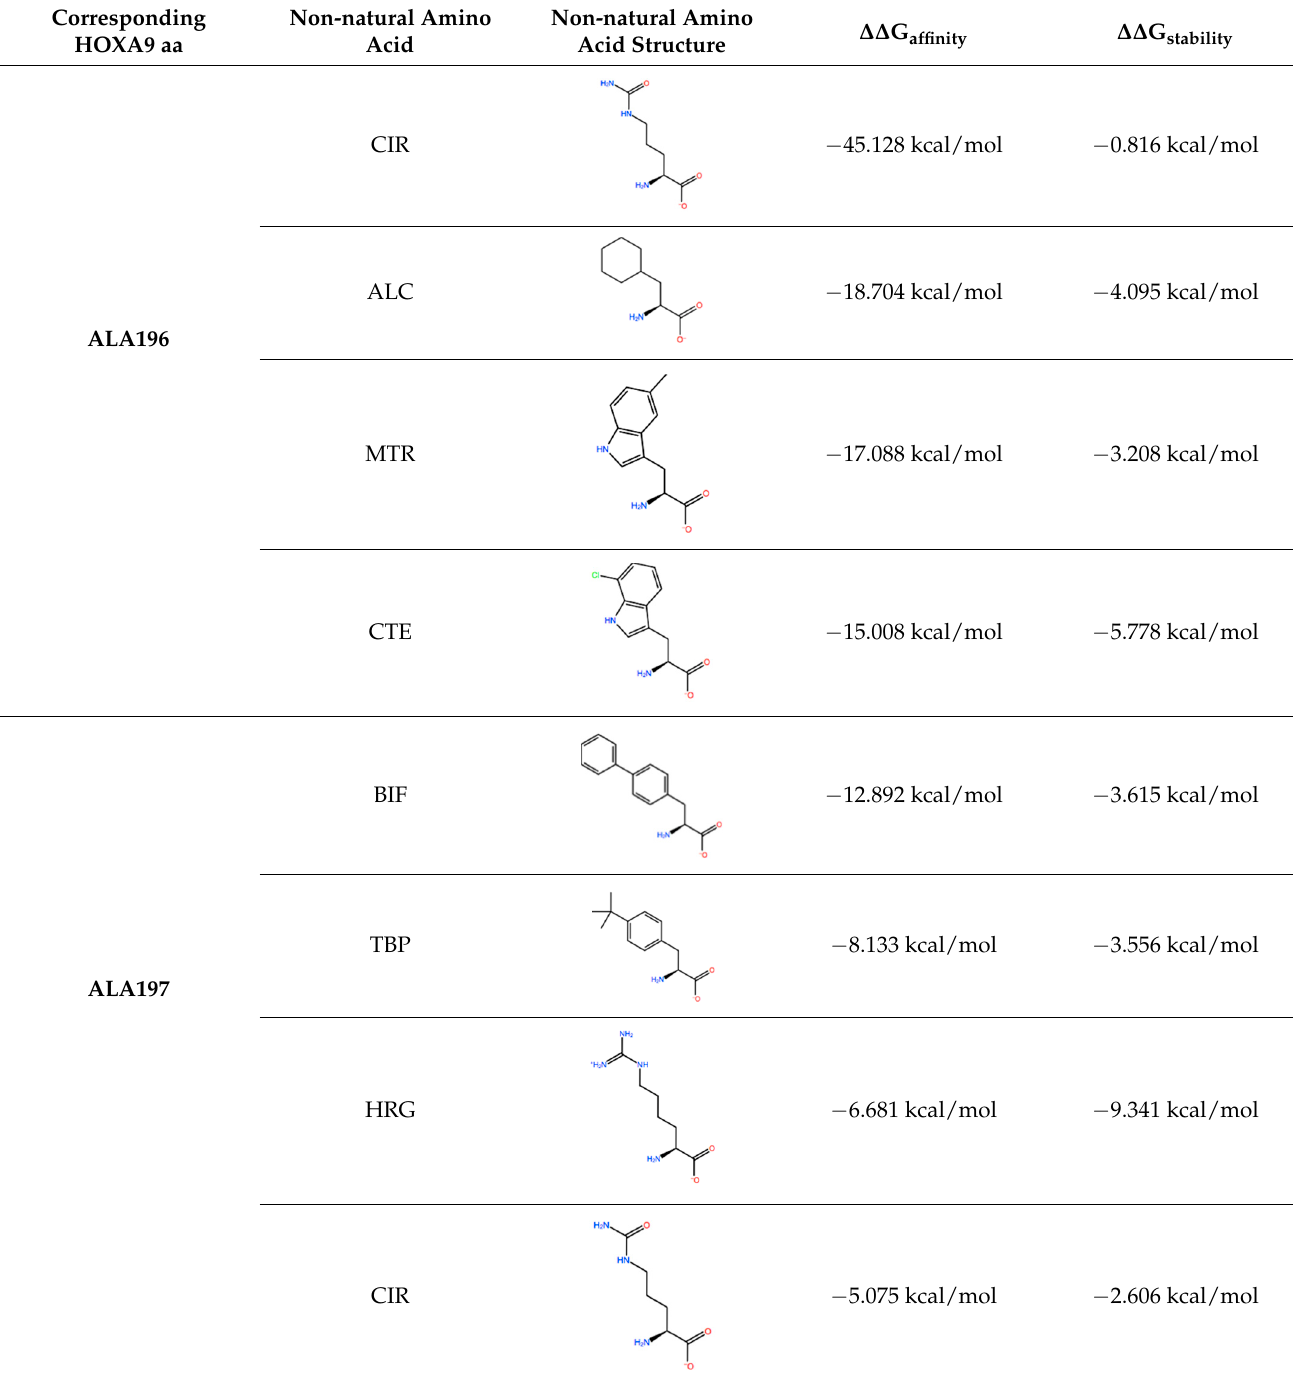
Table 3. The best four non-standard amino acids selected through residue scanning calculations according to ΔΔ G affinity and ΔΔ G stability .